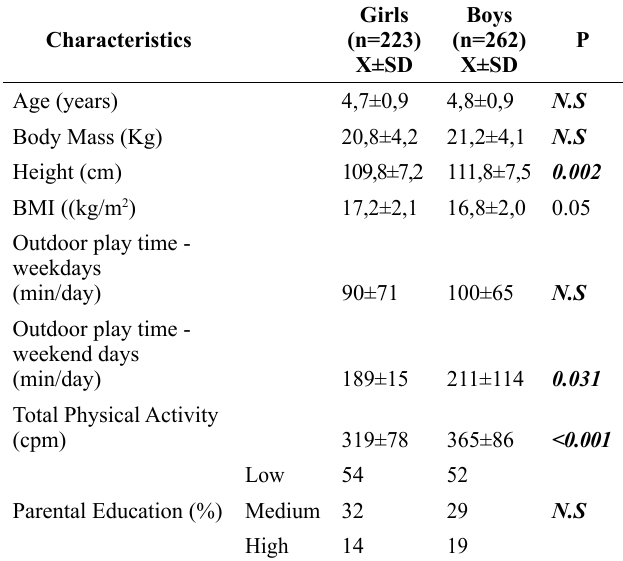
Table 1- Characteristics of the participants by